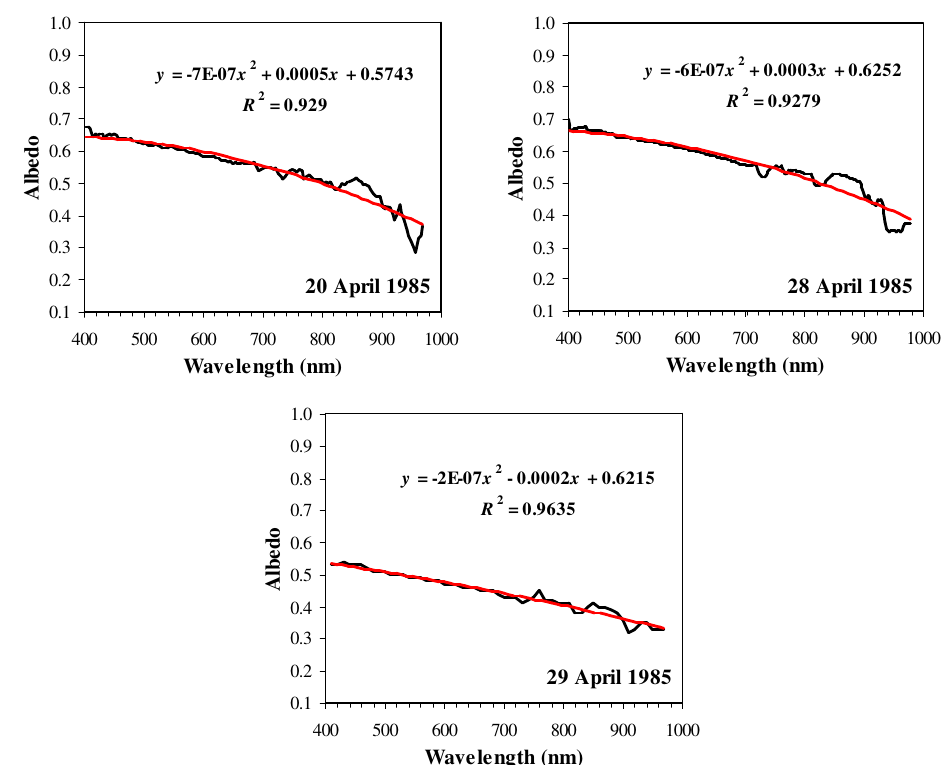
Figure 9. Spectral dependence of snow albedo (Lake Ladoga) in the visible and infrared spectra, as deduced from airborne observations conducted on 20 April 1985 (cloudy, wet snow, 402–968nm, with a step of 4nm), 28 April 1985 (wet snow, 401–978nm), and 29 April 1985 (wet snow, 410–970nm, with a step of